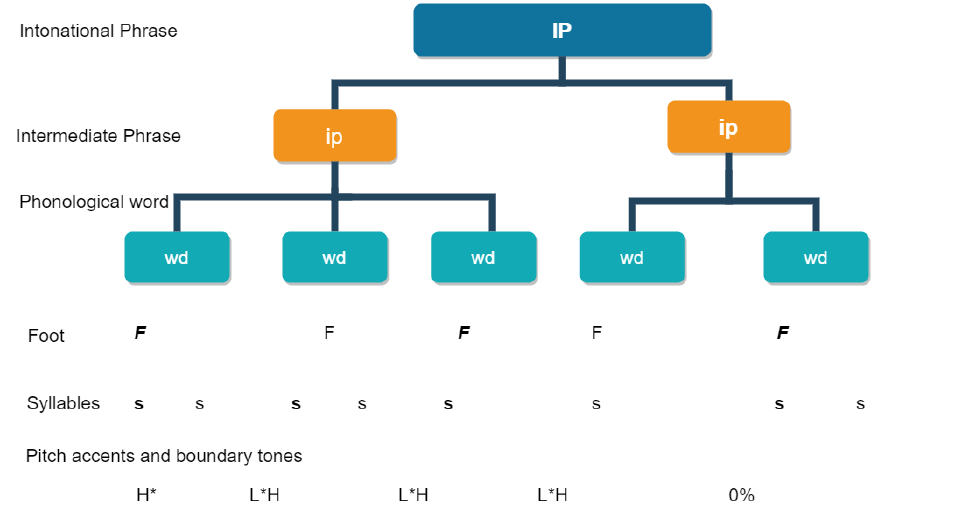
Figure 7. Diagram of an utterance [Are you growing limes][or lemons?] showing hierarchically layered prosodic structure at the syllable, foot, word and phrase levels. Prominent positions are given in boldface.